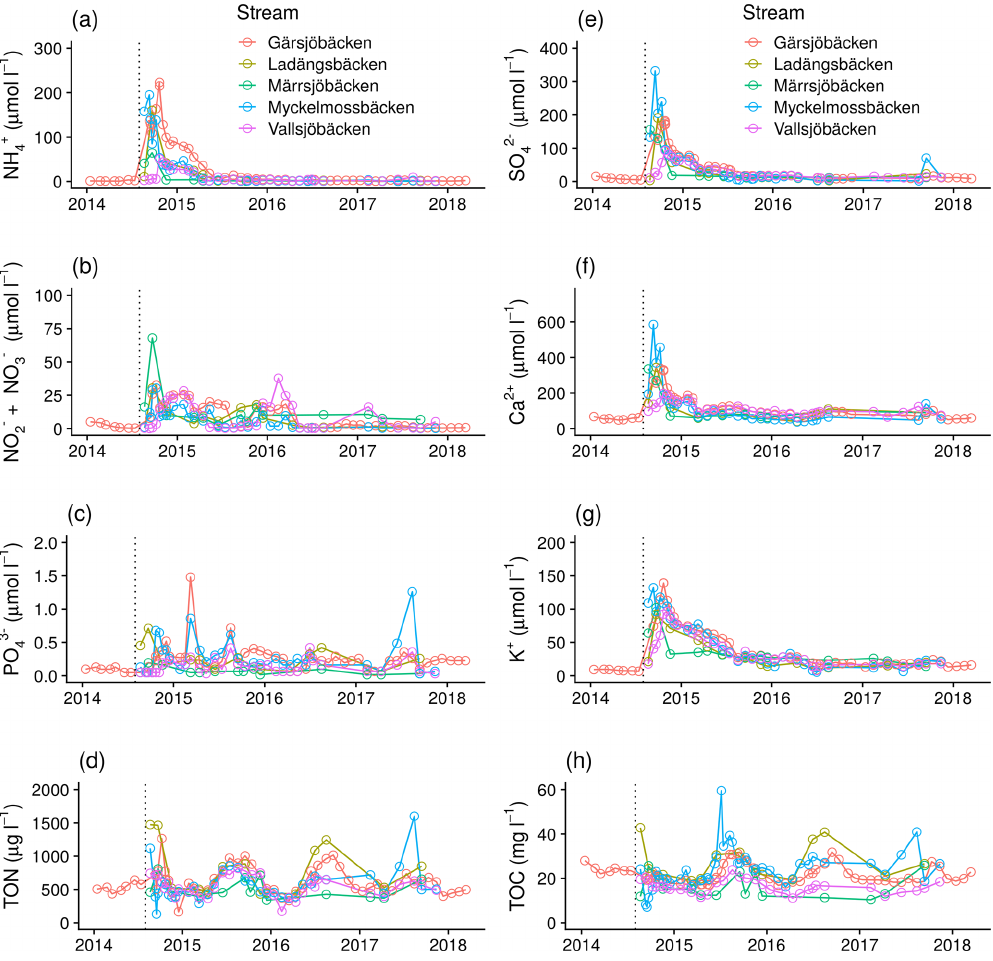
+ NO − , (b) NO − , (c) PO 3 − , 4 3 3 4